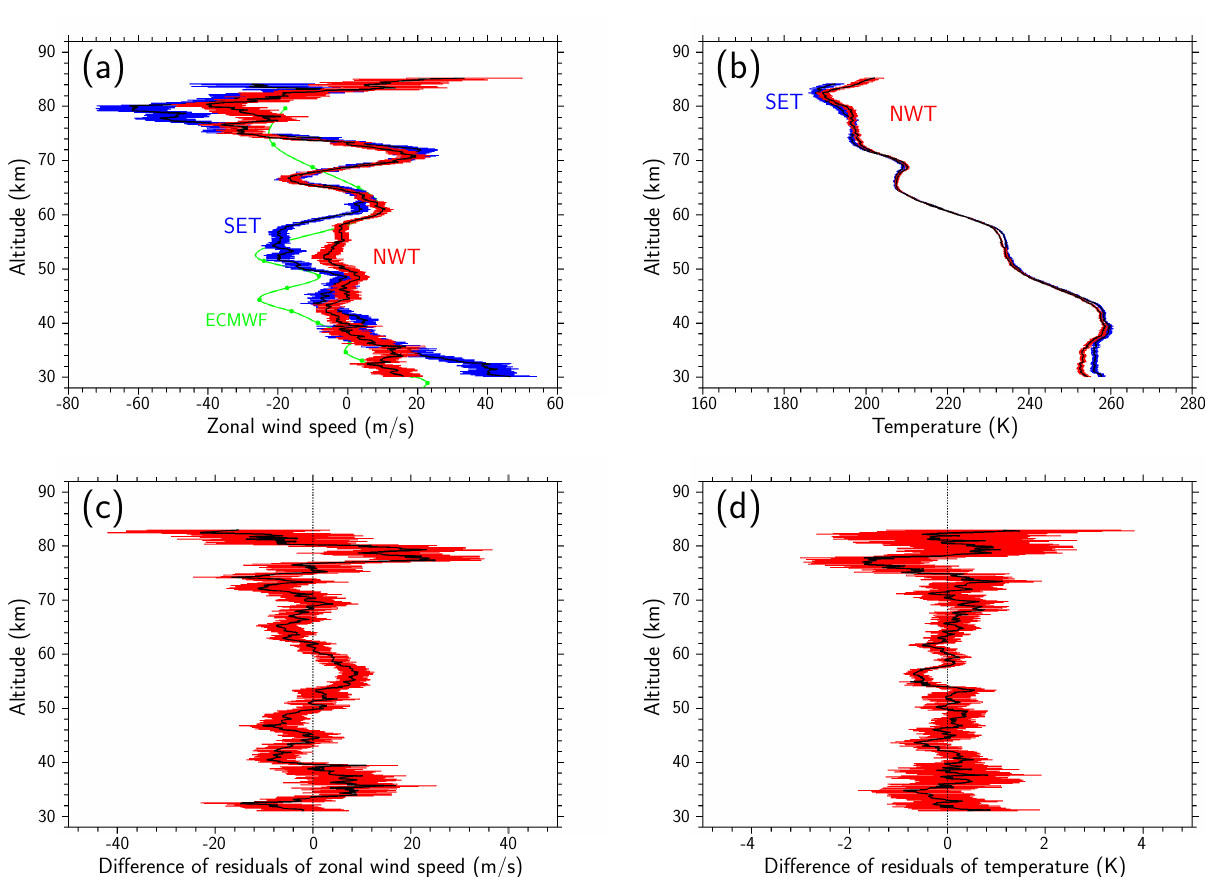
Fig. 6. Vertical profiles of zonal wind speed and temperature on 25 January between 03:25UT and 07:15UT obtained by NWT (red error bars) and SET (blue error bars) and the difference of their respective residuals. (a) Zonal wind speed: green line shows ECMWF data for 06:00UT (dots mark the model levels). (b) Temperature. (c) Wind difference between NWT and SET after subtracting a polynomial fitted background wind profile (see text for details). (d) Same as panel (c) but for